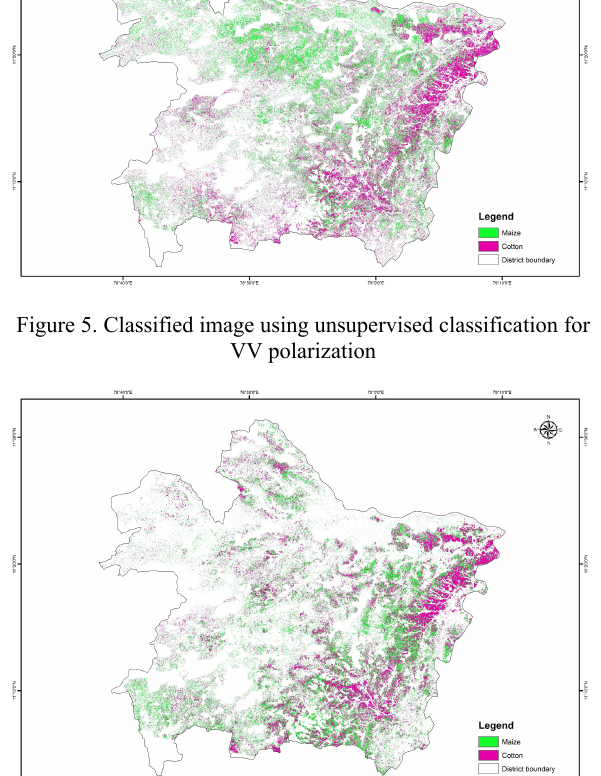
Figure 7. Classified image using unsupervised classification for